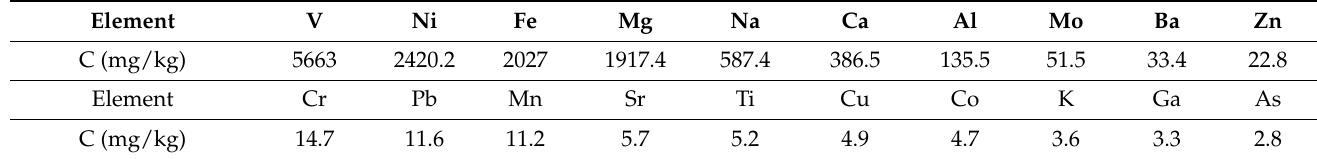
Figure 2. XRF analysis for Fly ash before treatment. Table 2. Concentrations of elements present in the waste before treatment obtained by ICP.